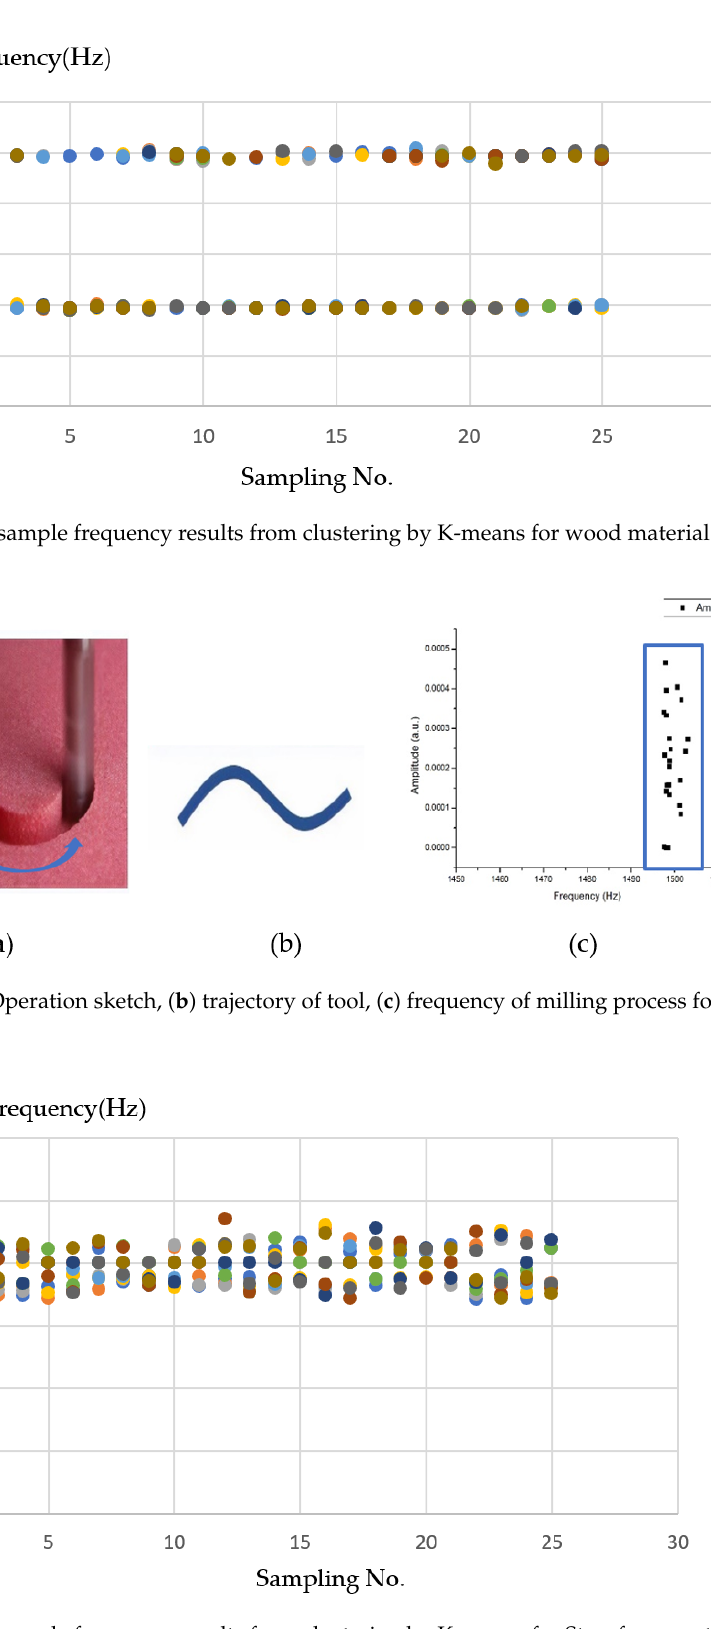
Figure 18. Ten sample frequency results from clustering by K-means for Styrofoam material.